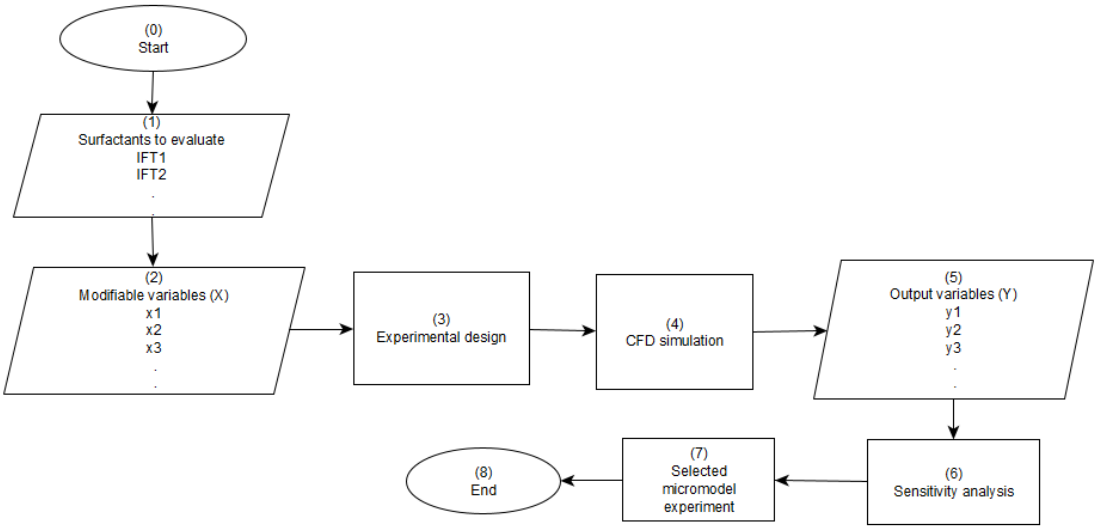
Figure 1. Flowchart to select a microfluidic experiment to evaluate the performance of surfactants during EOR through CFD simulations.